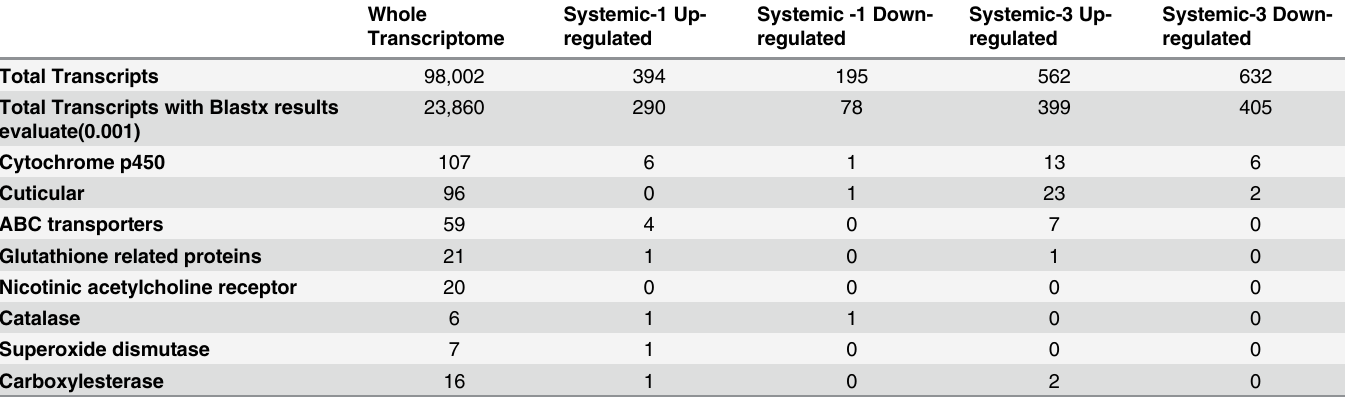
Table 4. Differentially expressed up- and down-regulated transcripts observed between two resistant populations compared to the Arlington Agri- cultural Research Station